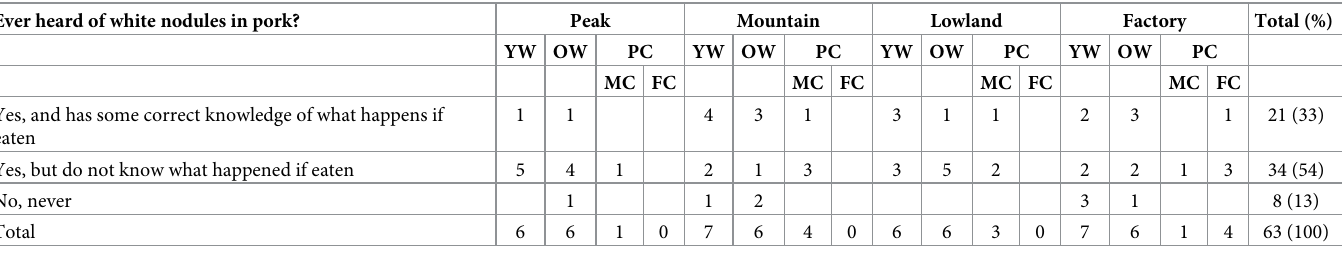
Table 4. Answers to the question “Have you ever heard of “white nodules” in pork?” from 63 informants. Ever heard of white nodules in pork?